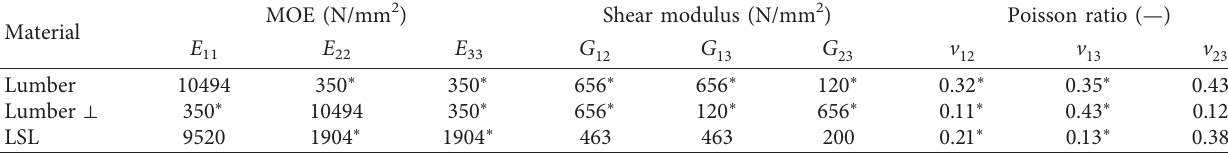
Table 4: Material properties in finite element models.